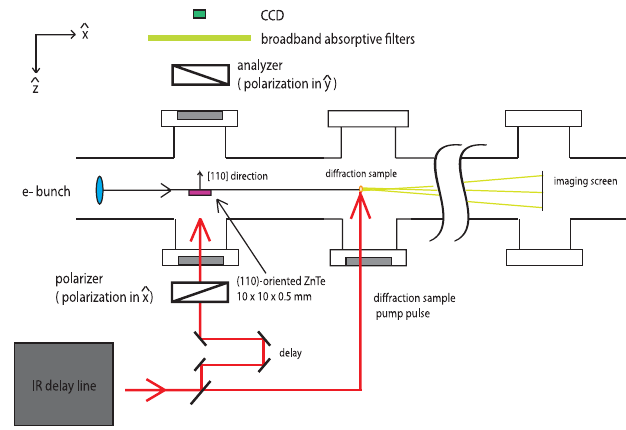
FIG. 2. (Color) Time-stamping scheme for ultrafast relativistic electron